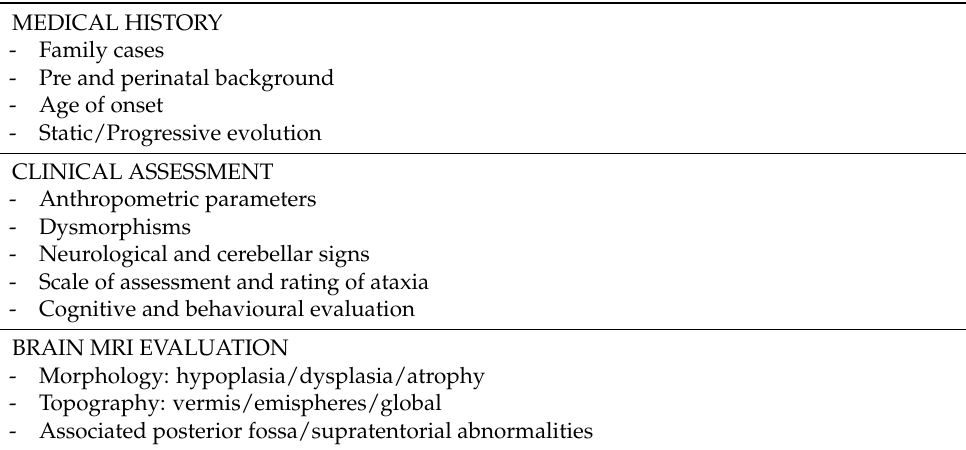
Table 1. Diagnostic approach in children with cerebellar